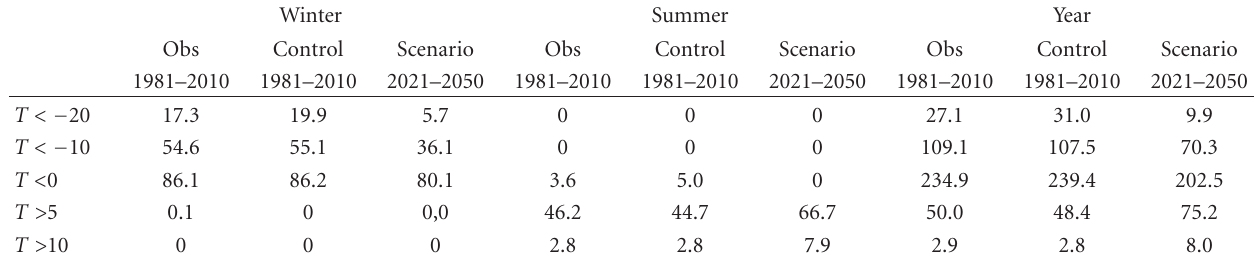
Table 9: Number of days per year with daily mean temperature ( T ◦ C) below or above threshold values at Svalbard Airport. Control and scenario values are based on postprocessed temperatures from